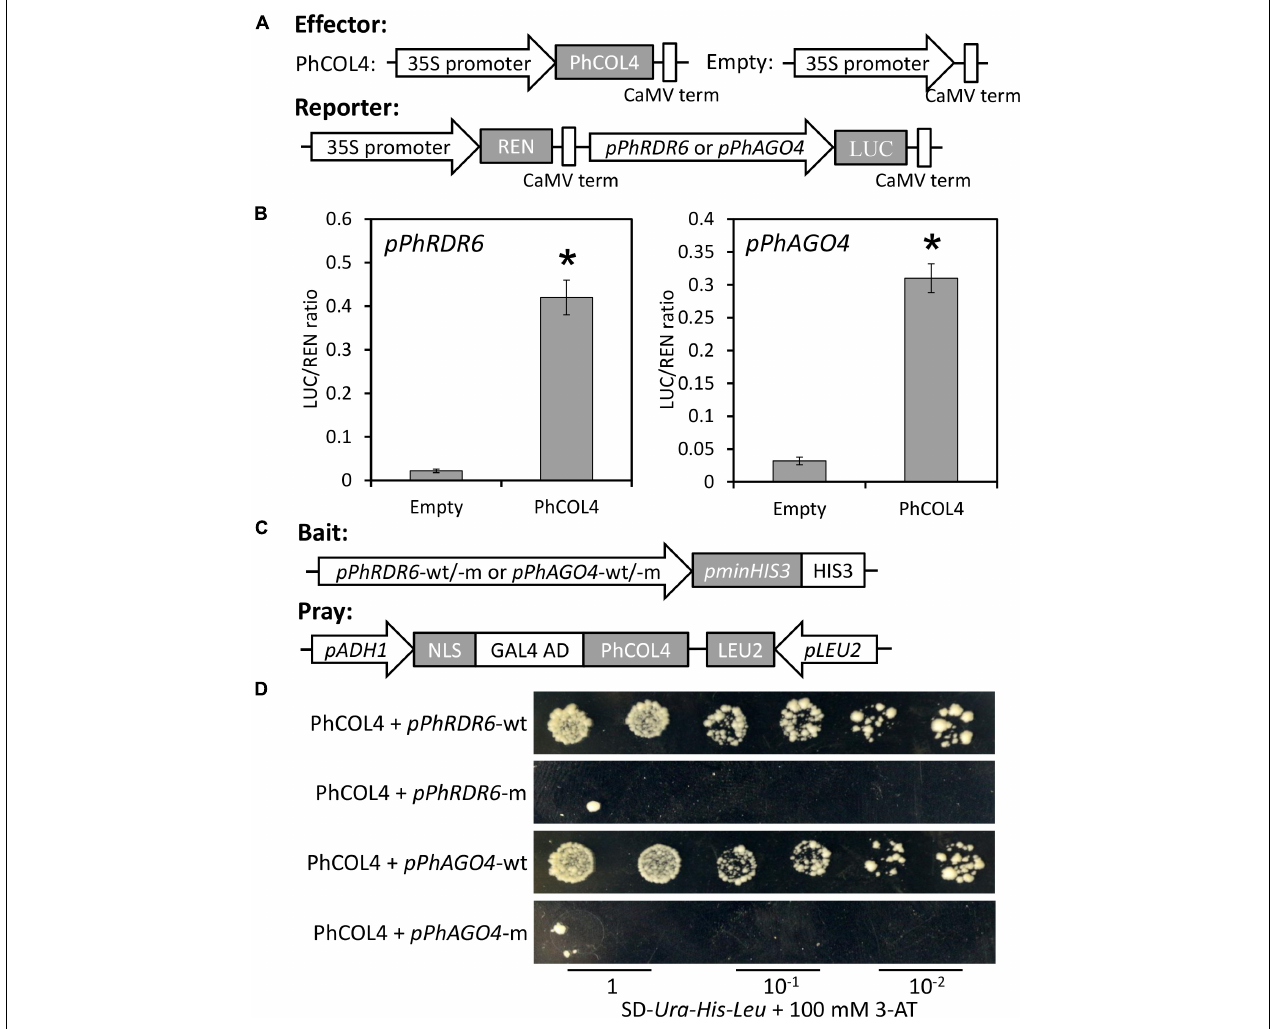
FIGURE 10 | Transactivation of PhRDR6 and PhAGO4 promoters by PhCOL4. (A) Schematic diagrams of the effector and reporter constructs for dual luciferase assay. REN, Renilla luciferase; LUC, firefly luciferase. (B) Dual luciferase assay of the pPhRDR6 and pPhAGO4 . The activation was expressed as a ratio of LUC to REN. Error bars indicate standard error of the mean from three biological replicates. Statistical significance was determined using Student’s t -test ( P < 0.05) and shown as asterisks. (C) Schematic diagrams of the bait and pray constructs for yeast one-hybrid assay. The fragments containing wild-type (wt) and mutant (m) PhCOL4-bound motifs were used for construction of bait vectors. (D) Growth of yeast cells transformed with the bait and pray plasmids on SD- Ura-His-Leu plates supplemented with 100 mM 3-aminotriazole (3-AT) at different